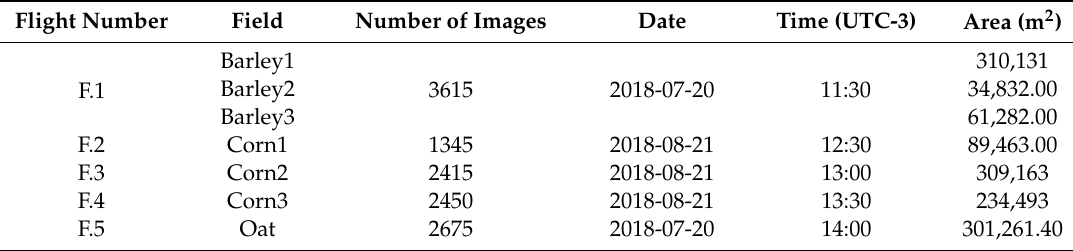
Table 1. Unmanned aircraft system (UAS) flight parameters.